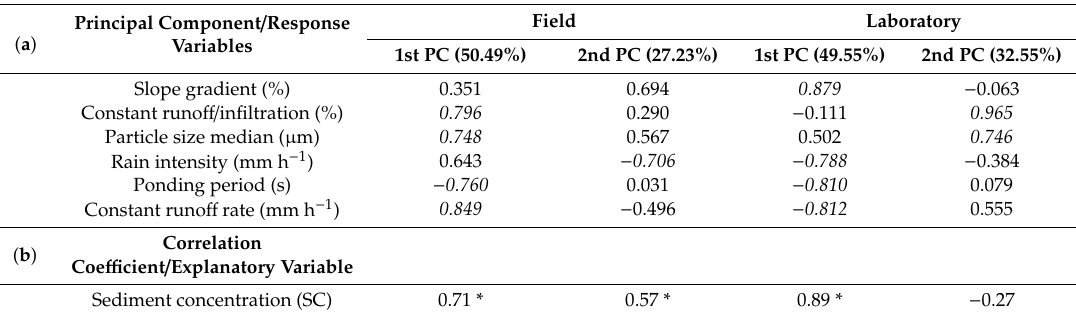
Table 4. Principal component loadings of the first two PCs and their explanatory power expressed as a percentage in parentheses ( a ). Field and laboratory experiments are both included. Influential loadings (loading outside the +/ − 0.70 interval) are in italics, and ( b ) correlation coe ffi cients between the PC scores and the response variable’s data series, significant at α = 0.1, are marked with an asterisk